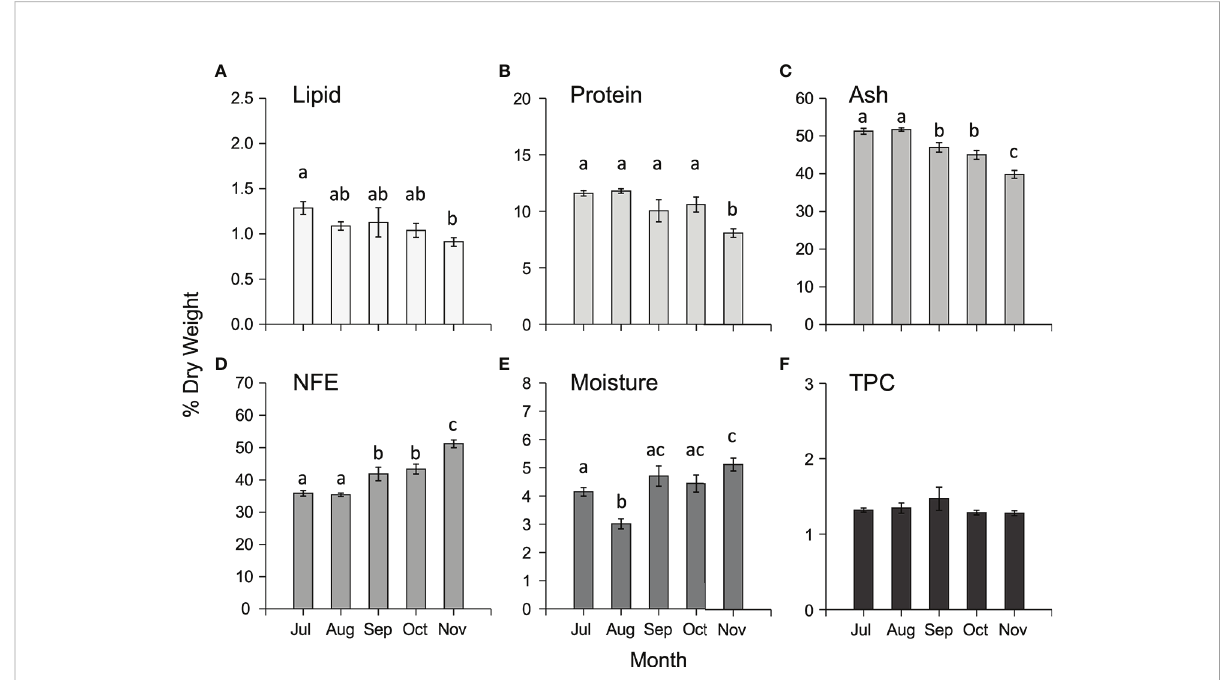
FIGURE 4 Mean (± SEM) proximate composition (expressed as % DW) including (A) lipid, (B) protein, (C) ash, (D) NFE, (E) moisture and (F) total phenolic content (TPC, expressed as mg g -1 DW) of cultivated M. pyrifera in south-east Tasmania along the cultivation period. Different letters above bars represent signi fi cant differences (P < 0.05) amongst harvest times from Tukey ’ s HSD